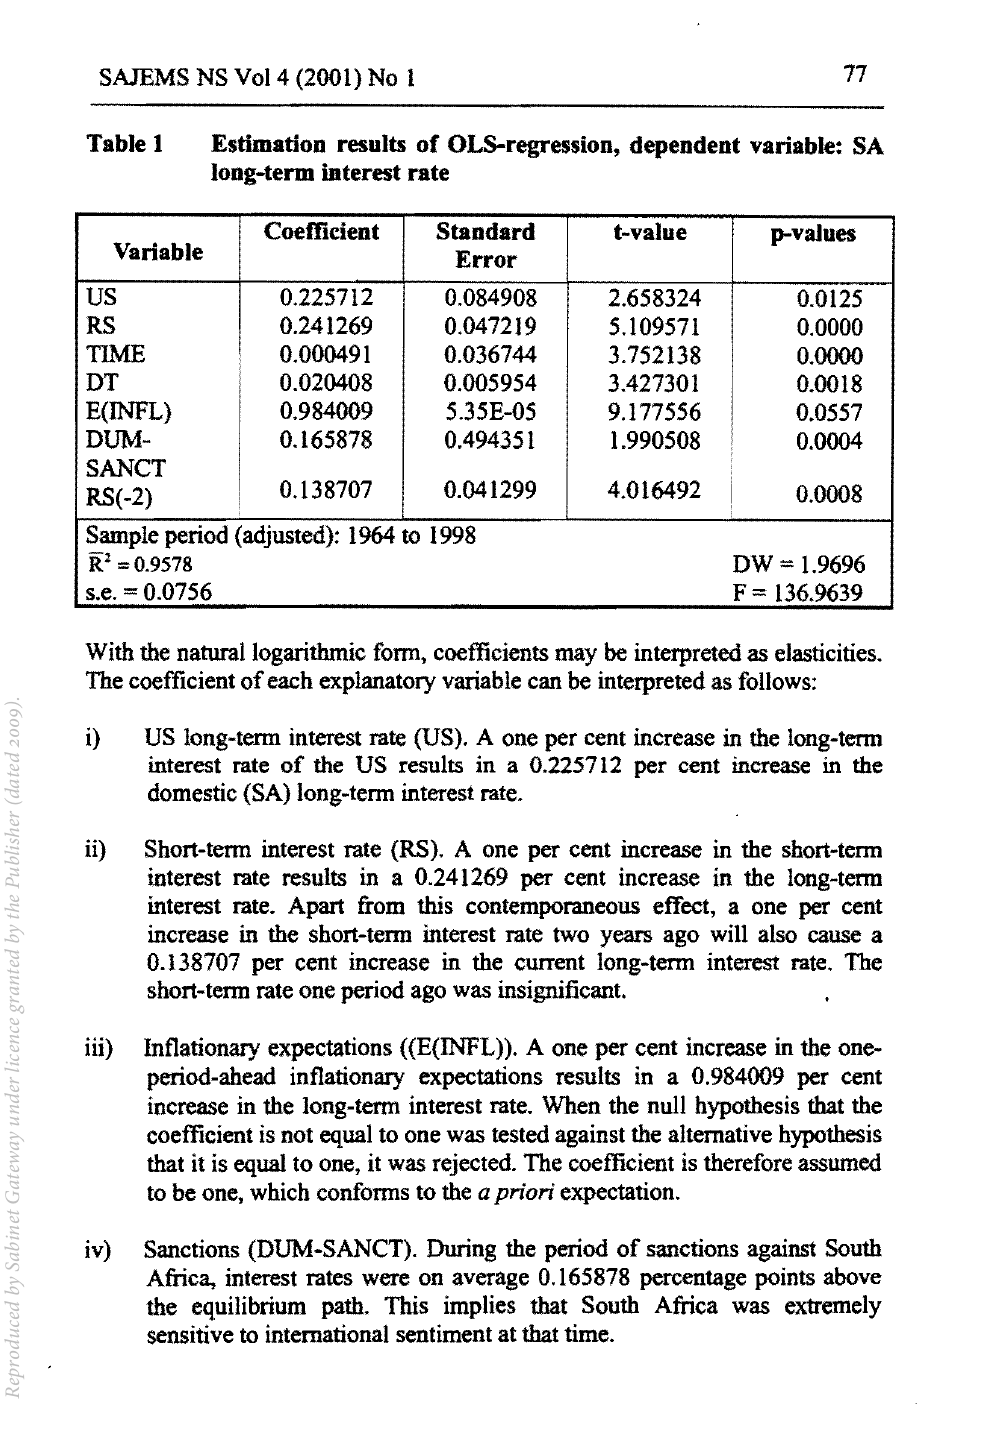
Estimation results of OLS-regression, dependent variable: